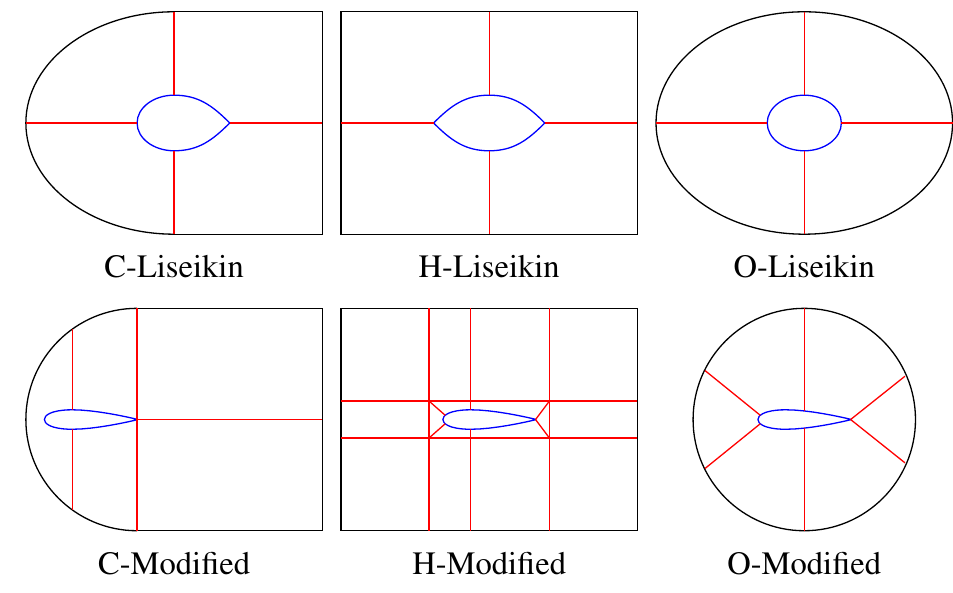
Figure 2. Original and modified mesh types for the block-structured mesh.